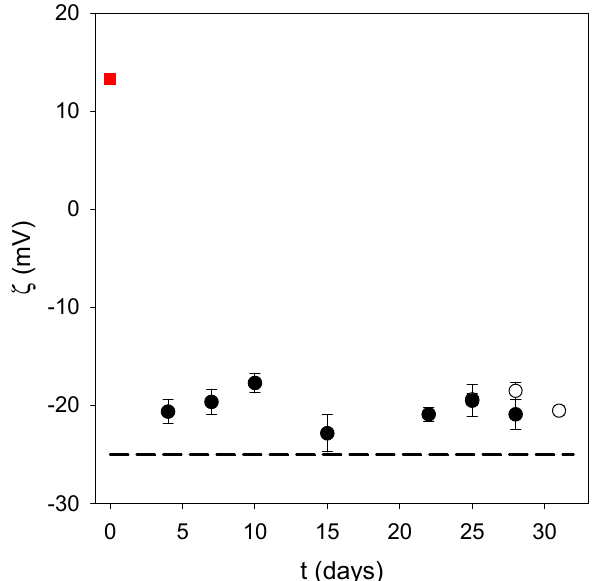
Figure 4. Zeta potential of PDA particles obtained after 6 h of oxidation of a 2 mg · mL − 1 dopamine solution in the presence of 20 mM NaIO 4 without added enzyme ( (cid:4) ) and in the presence of ALP at 1 mg · mL − 1 (two independent syntheses: ◦ , • ). The particle suspension was dialyzed against Tris buffer as described in the Materials and Methods section. Each data point corresponds to the average over three measurements on a same batch of particles, and the error bar corresponds to one standard deviation. The dashed line corresponds to the zeta potential of a 1 mg · mL − 1 solution of the enzyme in Tris buffer, namely ( − 25 ± 5) mV.